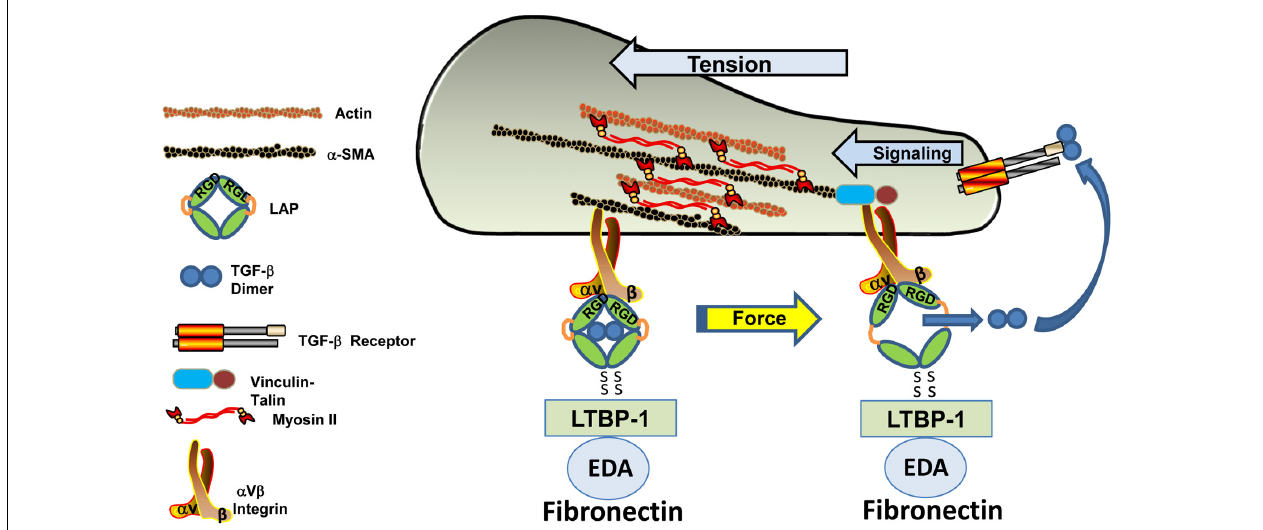
FIGURE 9 | Tension-dependent release of active TGF- β from the LAP cage. The ternary large latent (LTBP/TGF- β /LAP) complex forms a bridge between an α V integrin bound to the RGD site on the latency-associated peptide and LTBP-1 tethered to the fibronectin-rich ECM. Actinomyosin-based contractility generates mechanical tension within this ternary complex inducing a conformational change in the LAP that releases the now-active TGF- β dimer that, in turn, occupies the TGF- β R to initiate downstream signaling.